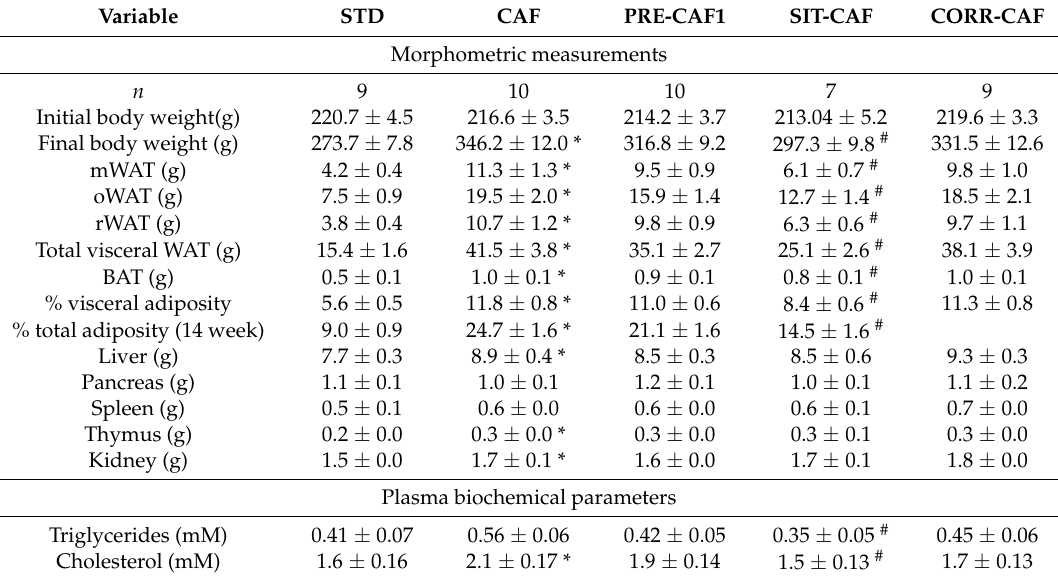
Table 2. Morphometric and biochemical characteristics of the groups analyzed at 17